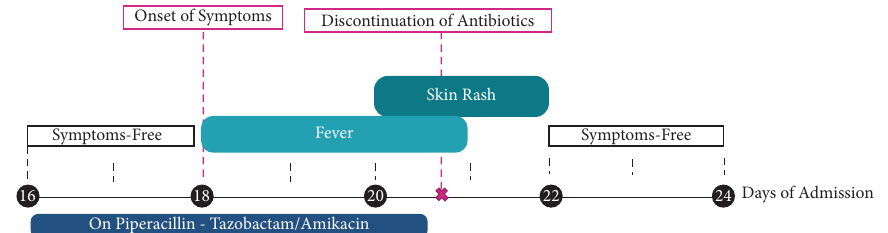
Figure 1: Patient timeline. Te timeline displays the patient’s course beginning from the initiation of the intravenous medications, subsequent symptoms, and the dramatic clinical resolution of symptoms after removal of the ofending